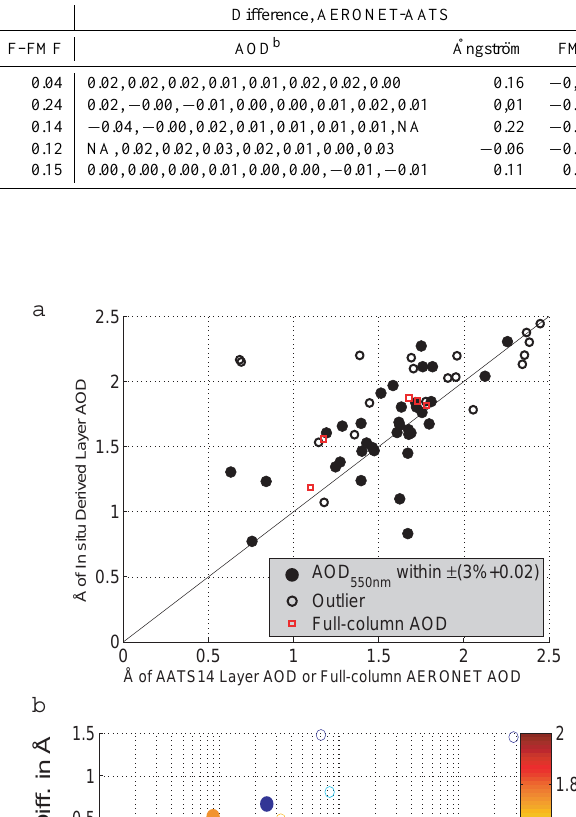
Table 1. Difference in optical properties during the AERONET fly-over events. Place and date Difference, in situ-AATS